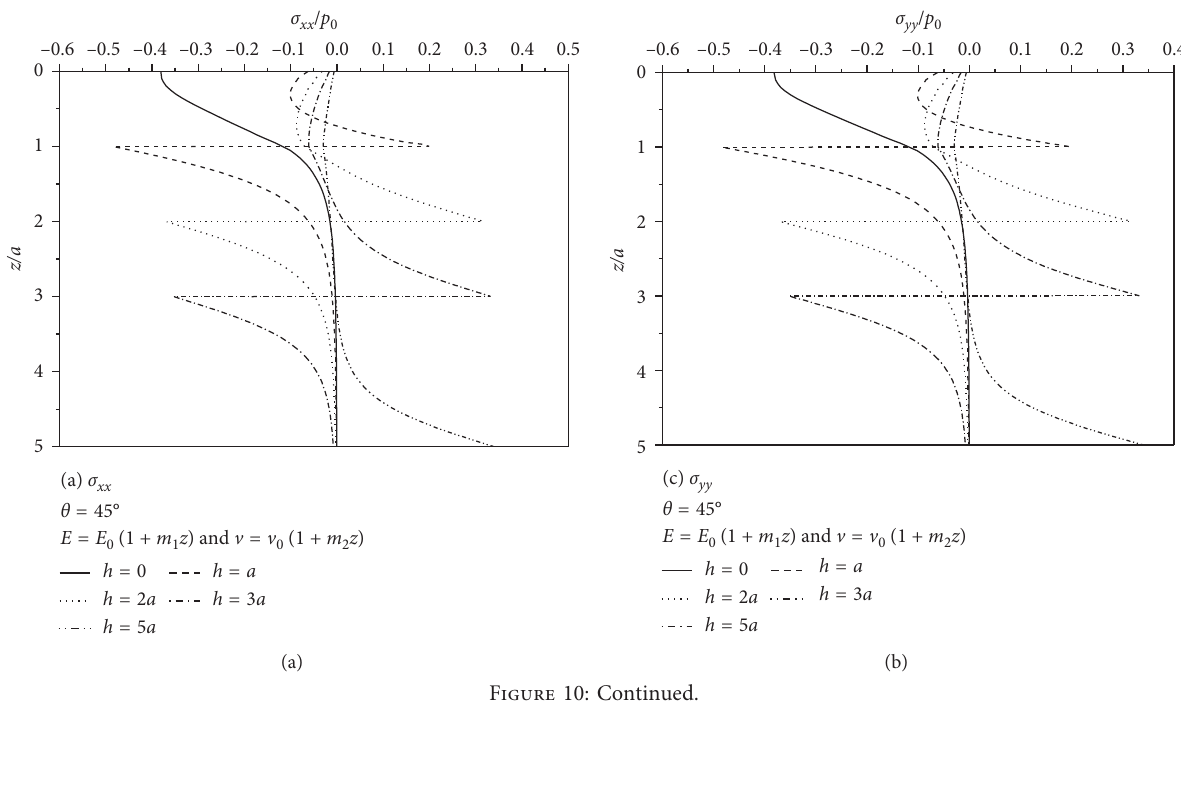
� a and θ � 45 ° for different h . (a) u x and u z for d